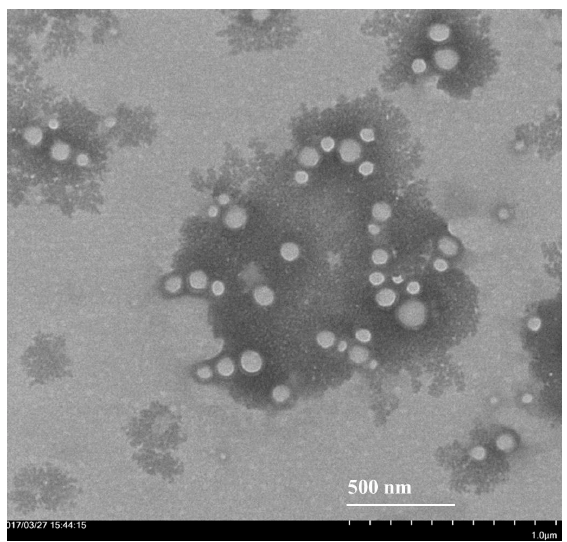
Figure 3. Transmission electron microscopic (TEM) image of ASLNs.